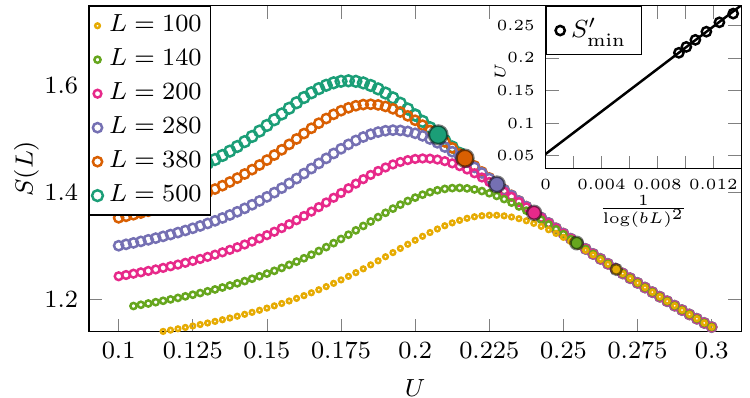
Figure 9: Central-cut entanglement entropy for L = 100 − 500 at f = − 30, dis- playing the finite-size features close to the KTT between the (cid:90) phases. The inflection points are highlighted. The inset shows the finite-size scaling of the position of the inflection points, confirming the thermodynamic transition at ≈ 0.0526 using U II c